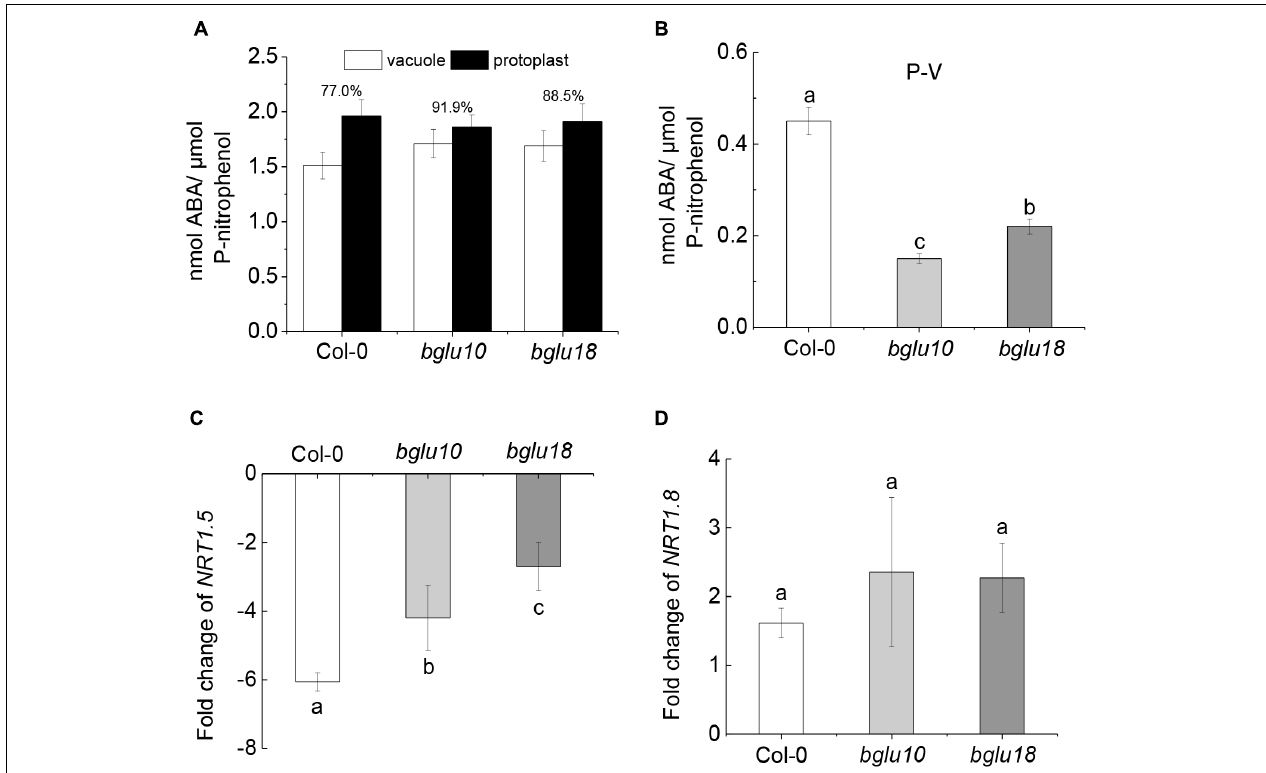
FIGURE 2 | Distribution of ABA content in Arabidopsis wild-type (Col-0) and ABA mutants ( bglu10 and bglu18 ) root cells under Cd stress and the effect of endogenous ABA on NRT1.5 and NRT1.8 . (A) ABA distribution between the vacuole and protoplast; values above the bars represent the percentage of vacuolar ABA relative to the total ABA in the protoplasts. (B) Total ABA accumulated in cytoplasm (P-V) calculated as total ABA in the protoplast – total ABA in the vacuole. (C) The fold change of NRT1.5 down-regulation in roots calculated as the expression of NRT1.5 under normal treatment divided by the expression of NRT1.5 under Cd stress. (D) The fold change of NRT1.8 up-regulation in roots calculated as the expression of NRT1.8 under Cd stress divided by the expression of NRT1.8 under normal treatment. Data represent means ± SE ( n = 4). Bars with the same letter indicate no significant difference at P < 0.05 level by the method of